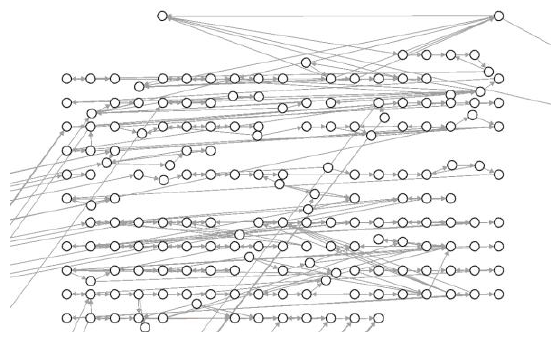
Figure 11. Perspective view on 4853 registered